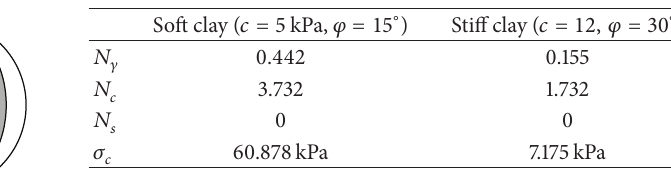
Figure 1: Cross-section of the collapse failure mechanism associating with a single circular tunnel in the (𝑦,𝑧) plane. Table 1: Critical collapse pressures of given soil